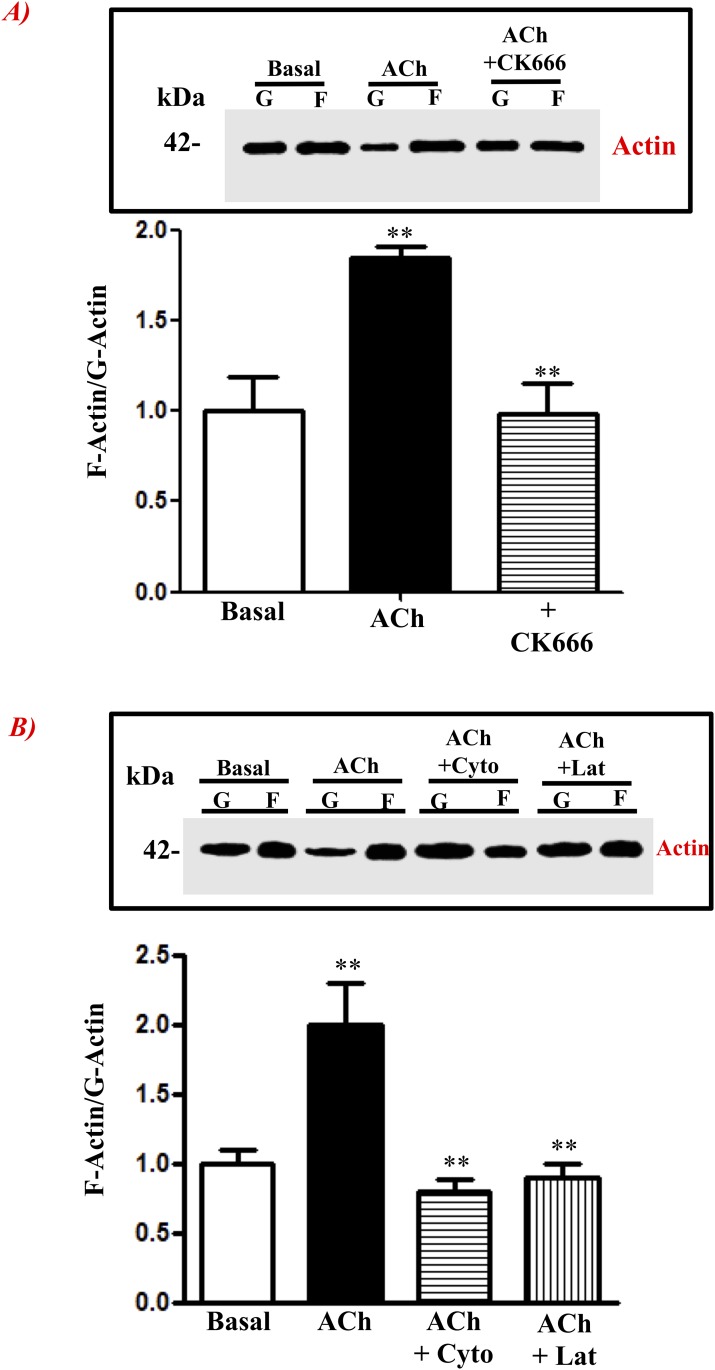
Arp2/3 complex-mediated increase in sustained actin polymerization by ACh.Cultured smooth muscle cells were pre-treated with Arp2/3 inhibitor (CK-666, 200 nM) A: or actin polymerization inhibitors (cytochalasin D, latrunculin, 10 μM) B: followed by 1 μM ACh for 10 min. Actin polymerization (F/G-actin) was measured by western blot using actin antibody. The results are expressed as densitometric values. Values are means ± SE of three experiments. **P<0.001.